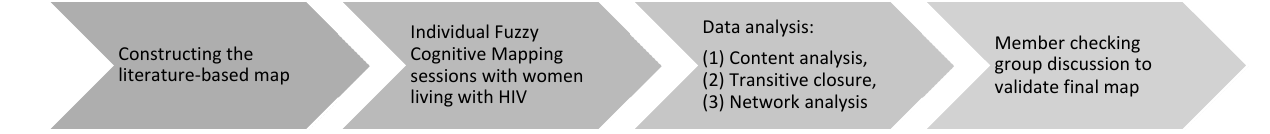
Figure 1. Study process overview .